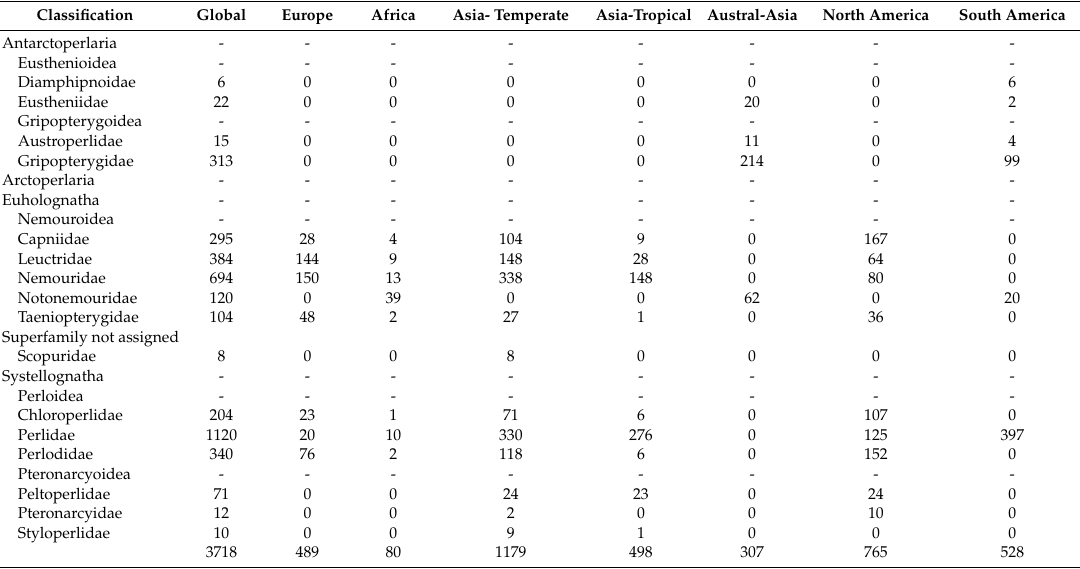
Table 1. Families of Plecoptera and number of species within them globally and across major regions of the world through 2018 [9].